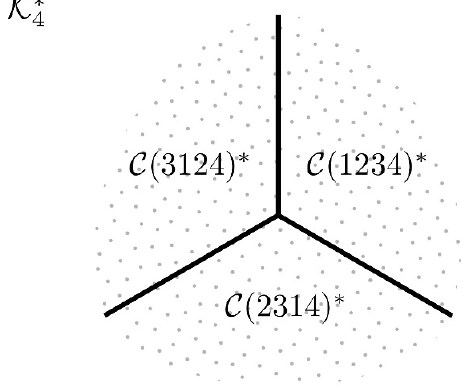
Figure 5 . The three dual cones C ( (cid:11) ) in K (cid:3)